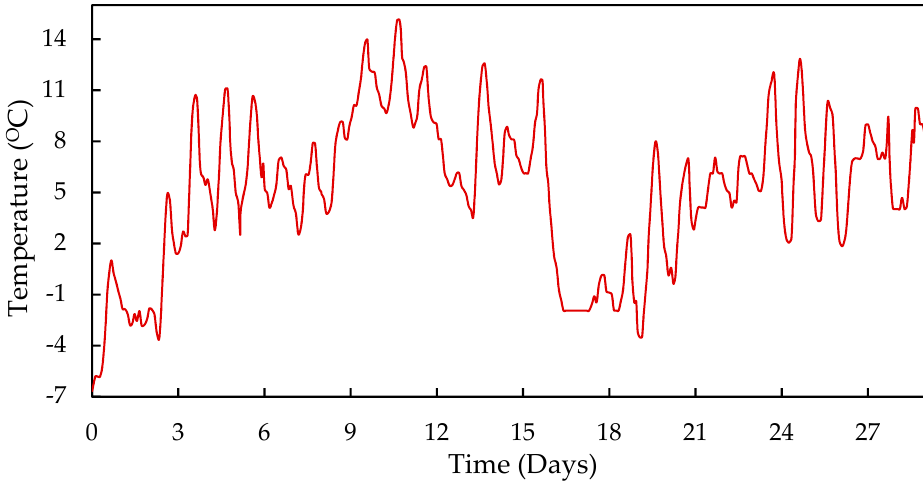
Figure 4. External varying temperature field.